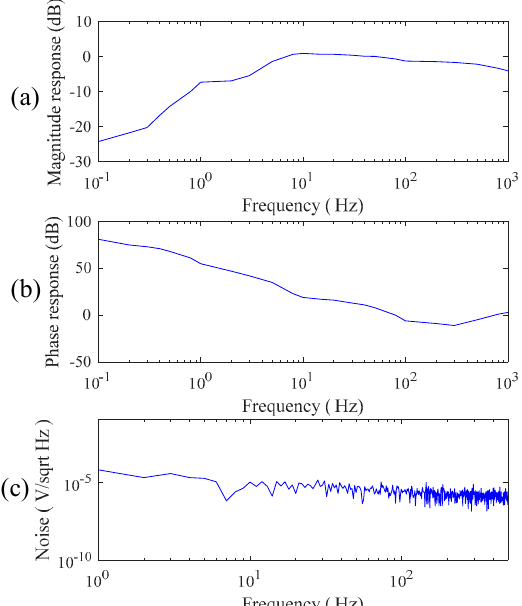
Figure 5. ( a ) The magnitude response, ( b ) phase response, and ( c ) referred noise spectrum of the proposed noncontact electrode.